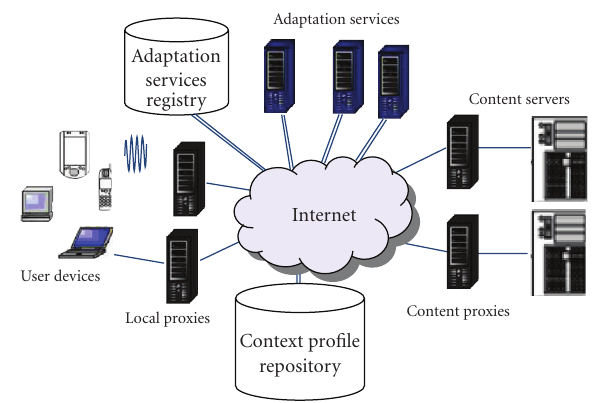
Figure 1: Distributed content adaptation framework